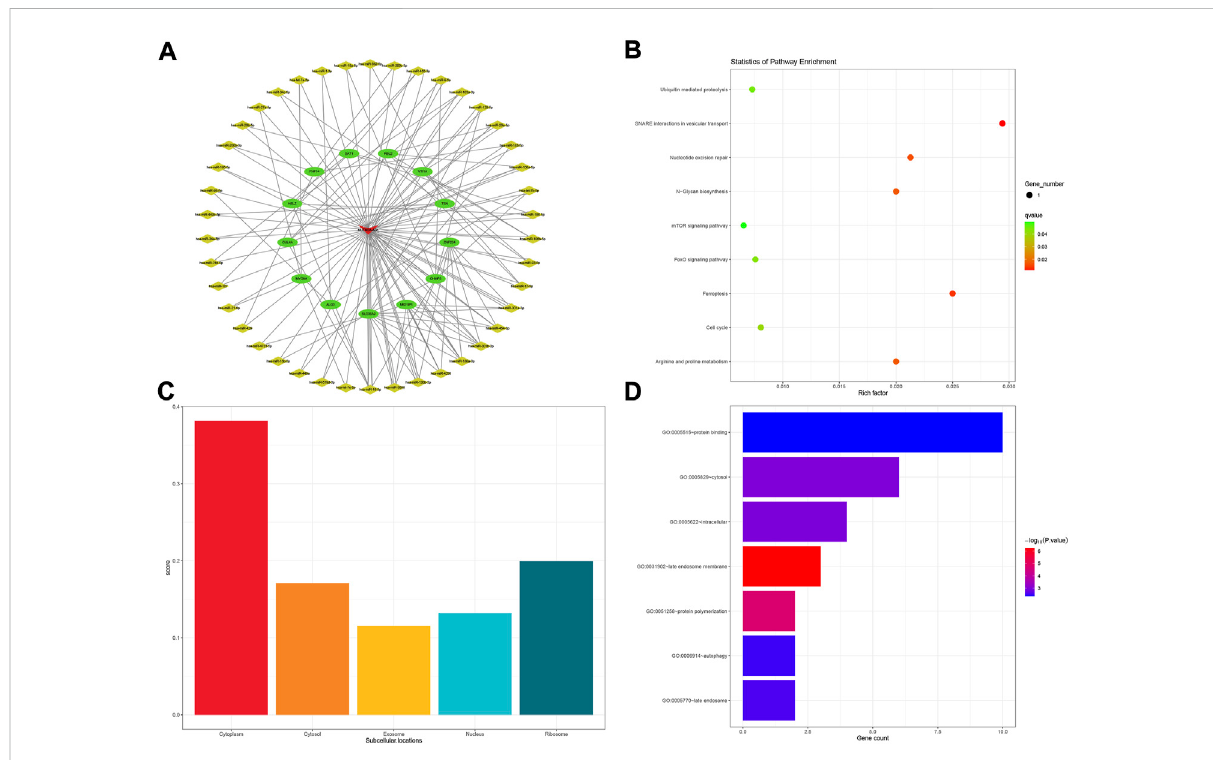
FIGURE 5 NUTM2A-AS1-related ceRNA subnetwork analysis. ceRNA network of NUTM2A-AS1 (A) . KEGG pathways enriched in NUTM2A-AS1 (B) . Subcellular location analysis for NUTM2A-AS1 (C) . GO biological process enrichment results for NUTM2A-AS1 (D)